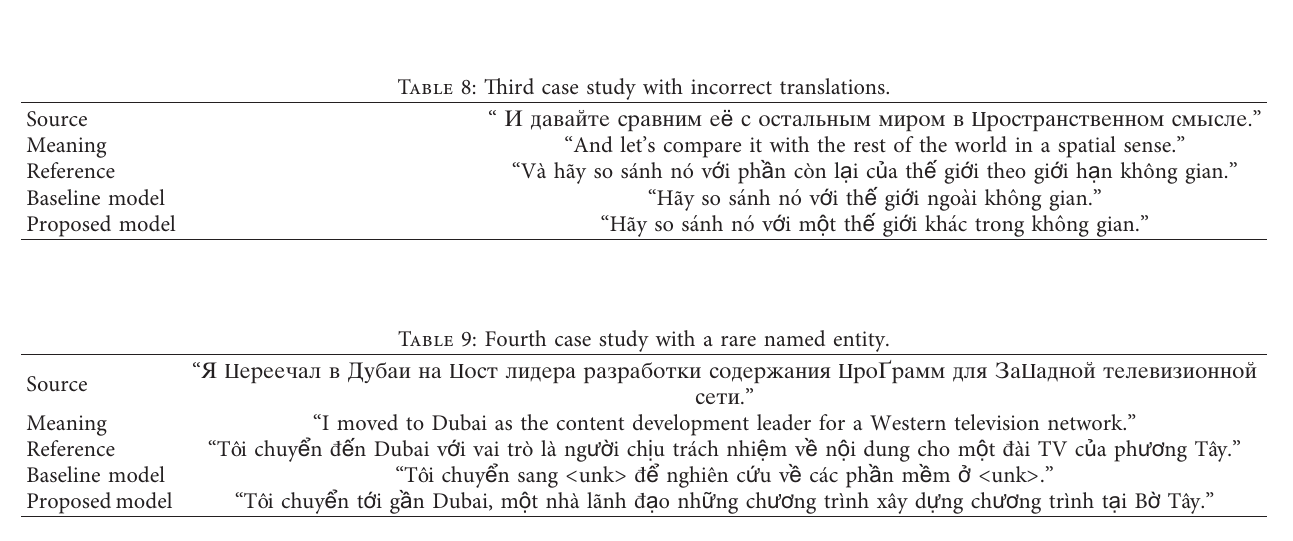
Table 10: Fifth case study with a rare compound. vuolxjpojrpcaoj> ;lpsjstfn9 .”